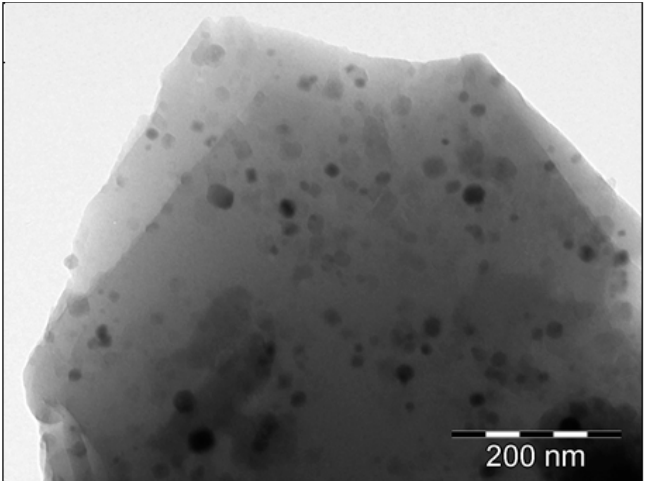
Figure 2. The XRD patterns of the Eu 3+ -doped SiO 2 -CaF 2 glass-ceramics annealed in air and addi- tionally annealed in reducing atmosphere; the XRD pattern of CaF 2 (PDF 35–0816) is also shown.